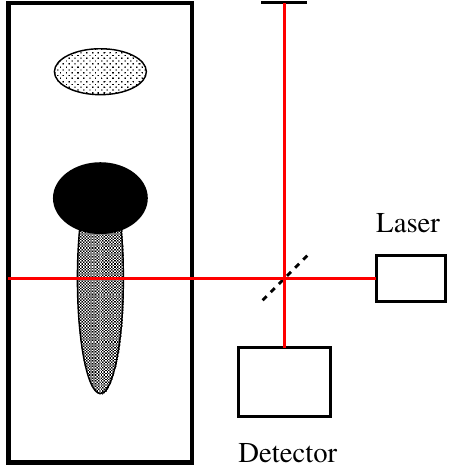
FIG. 29. (Color) Schematic layout of the interferometric ther- mometer proposed to measure temperature variations following energy deposition by the disrupted beam in the water